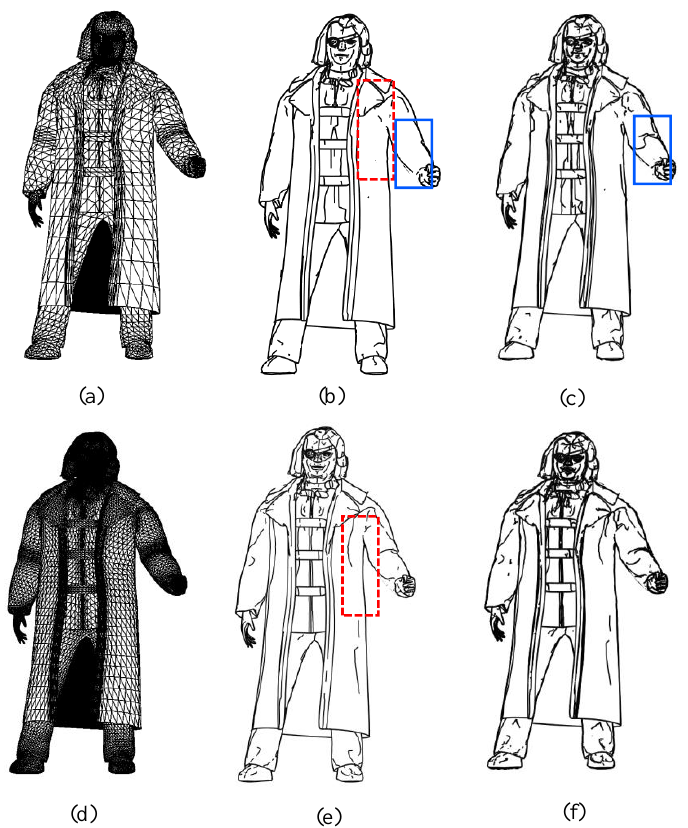
Figure 7. Feature line extraction of the 3D model according to the number of subdivision surfaces performed: ( a ) 1 time, wire frame; ( b ) 1 time, first line combination; ( c ) 1 time, second line combination; ( d ) 2 times, wire frame; ( e ) 2 times, first line combination and ( f ) 2 times.